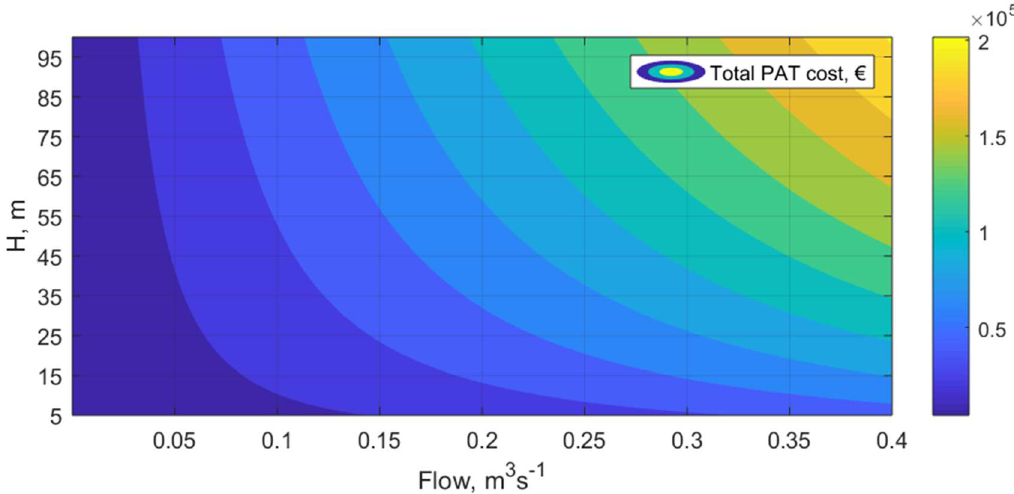
Figure 10. Total PAT cost according to flow and head.